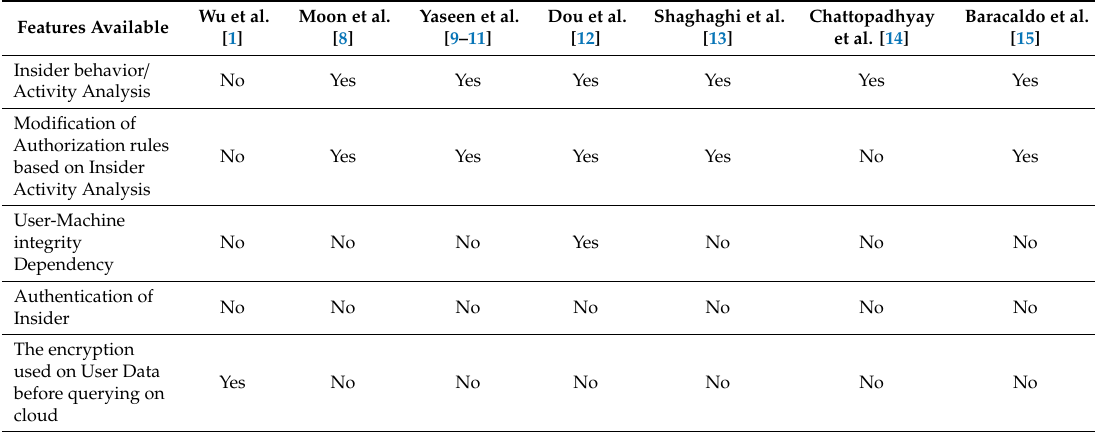
Table 1. Comparison of di ff erent techniques against an insider